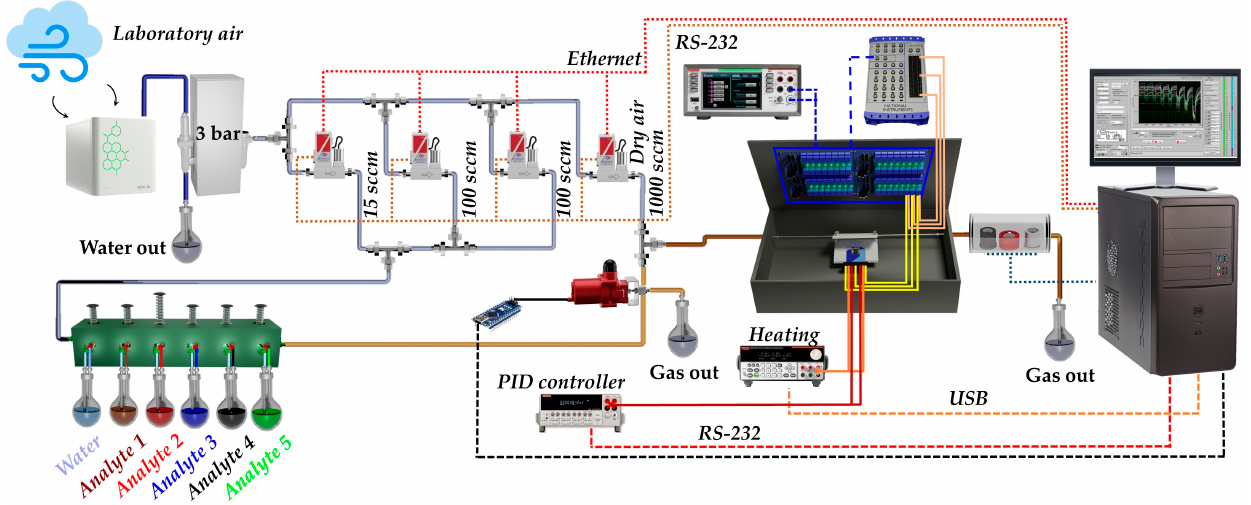
Figure 2. The experimental setup to measure the chemiresistive response of Ti 0.2 V 1.8 C MXene-based sensor chip which consists of the gas-delivery part based onmixing the dried lab air with few test analyte vapors, including H 2 O, yielded via bubbling to the gas line, and read-out electronics em- ploying resistance measuring of number of on-chip sensor elements via a multiplex card.